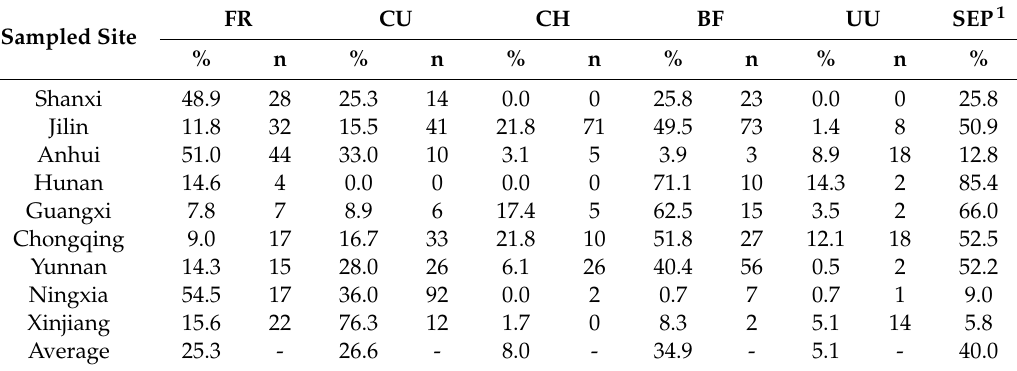
Table 1. Percentage (%) and number of questionnaires (n) of corn stover field retention (FR), commercial utilization(CU),cookingandheating(CH),burninginfield(BF),unplannedutilization(UU),andsurplus that could be used for ethanol production (SEP) at di ff erent sampled sites in 2015.